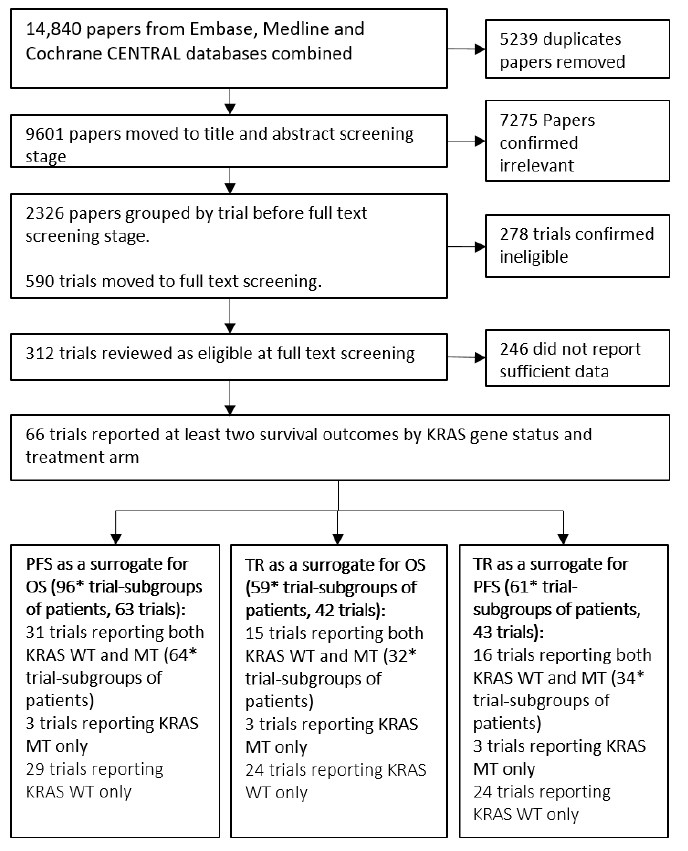
Figure 1. Flow diagram of the systematic review process. Groups of patients are either Kirstan rat sarcoma (KRAS) wild-type (WT) or KRAS mutant (MT) patients from a trial. PFS = Progression Free Survival, OS = Overall Survival, TR = Tumour Response. * 2 trials were multi-arm trials and reported two randomised treatment contrasts for each KRAS gene